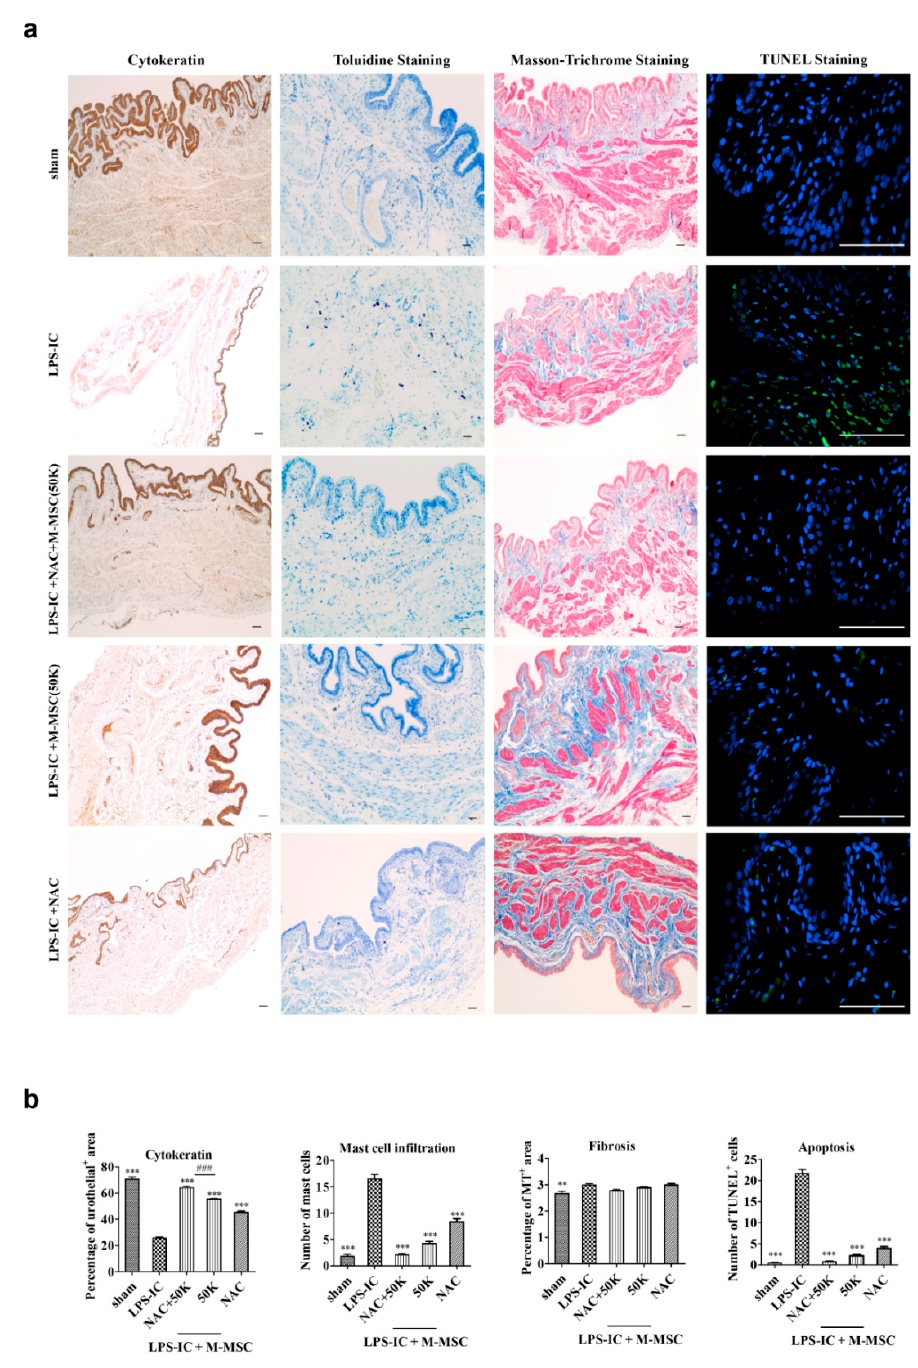
Figure 3. Injection of NAC and 50K M-MSCs ameliorated histological abnormalities in the bladders of LPS-IC rats. ( a ) (i) Cytokeratin immunostaining (magnification ×40, scale bar = 200 μ m), (ii) Toluidine blue staining (magnification ×100, scale bar = 200 μ m), (iii) Masson’s trichrome staining (magnification ×100, scale bar = 200 μ m), and (iv) TUNEL (magnification ×400, scale bar = 100 μ m) of bladder tissue of LPS-IC rats at one week after injection of the indicated number of NAC or M-MSCs (50K, K = thousand) or PBS. The arrows indicate infiltrated mast cells (ii) or apoptotic cells (iv). sham: sham-operated. ( b ) Quantification of the histological staining. Three representative areas per slide were randomly selected from five independent animals. Data ( n = 15) were normalized against those in sham-operated rats and are presented as the mean ± SEM. ** p < 0.01 and *** p < 0.001 were compared with the LPS-IC group; # p < 0.05, ## p < 0.001, and ### p < 0.001 were compared with the NAC + 50K group according to a one-way ANOVA using the Bonferroni post-hoc test.